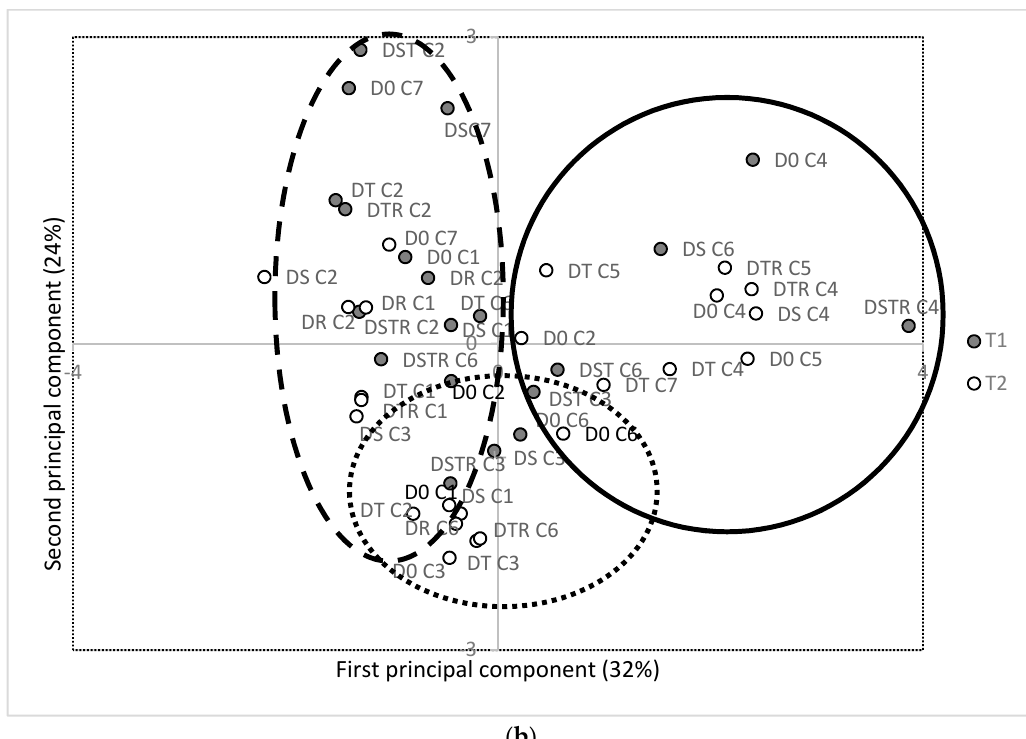
Figure 3. Loading ( a ) and score ( b ) plot from principal components analysis of amylose content (AmC), gel consistency (GC), gelatinisation temperature (GT), total antioxidant capacity (TAC), total phenolic content (TPC), and total protein content (Prot) in grains of rice cultivars stressed with drought at different development stages. Treatments corresponding to high TAC, TPC, and protein content are encircled by a full line, whereas a dashed line encircles the treatments corresponding to high or low eating and cooking qualities (AmC, GC, and GT), and a dotted line encircles the treatment corresponding to low content of all analyzed nutritional quality traits. T1: 26/23 °C; T2: 30/27 °C; DS: Drought treatment at seedling stage; DST: Drought treatment at the seedling and